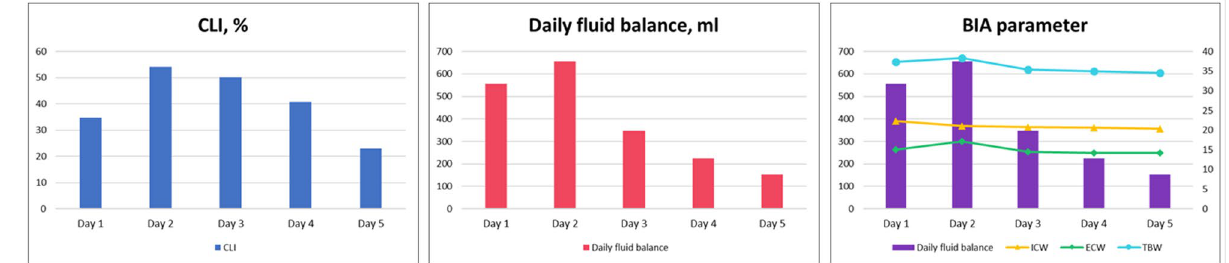
Figure 2. Daily variations of each volumetric variable during the first 5 days after estimated blood loss between 300 and 1000 ml during surgery were 151 (79.5%), those with minimal bleeding of less than 100 ml were 16 (8.4%), and those with massive bleeding of 1500 ml or more were 11 (5.8%). The amount of estimated blood loss of the participants was checked the normality and followed a normal distribution. Lengths of ICU stay and hospital stay were 6 ± 7.1 days and 24.3 ± 18.7 days, respectively. Patients with shock status accounted for 17.9%. ICU mortality and in-hospital mortality were 5.3% and 20.5%, respectively (Table 1). Daily values of volume assessment for 5 days are shown in Table 2 and Fig. 2. CLI, daily fluid balance, and ECW ratio had the highest values on Day 2, showing a decreasing trend after that. The number of patients with overhydration status was the highest on Day 1 at 136 (71.6%) and Day 2 at 135 (71.1%), followed by a decline to 55.8% on Day 3. Comparable analyses between OH and NH on Days 1, 3, and 5 are shown in Fig. 3. On Days 3 and 5, SOFA score at ICU admission, postoperative morbidity, and length of hospital stay, length of ICU stay, ICU mortality, and in-hospital mortality were significantly higher in OH than in NH. In the univariate analysis comparing postoperative complications and mortality, the ECW ratio > 0.390 on the postoperative days 1 and 2 did not show any significant results but were only derived significantly on the 3rd day after surgery. On the other hand, the ECW ratios on the days 1 and 2, which are continuous values, were significant. Results of multivariate analysis to identify predisposing factors of postoperative morbidity occurrence and in-hospital mortality are presented in Table 3A,B. Postoperative morbidity [odds ratio (OR) 1.163, 95% CI 1.038–1.304, p = 0.009] and in-hospital mortality (OR 3.151, 95% CI 1.474–6.737, p = 0.003) were significantly more likely to occur in patients with higher SOFA scores at ICU admission. Postoperative morbidity (OR 1.182, 95% CI 1.056–1.323, p = 0.004) and in-hospital mortality (OR 2.040, 95% CI 1.007–4.590, p = 0.045) were more likely to occur in the group of patients with overhydration status on Day 3. For predicting postoperative mor- bidities, cut-off levels of SOFA score at admission and ECW ratio at Day 3 estimated by ROC curve were 3.5 [area under curve (AUC): 0.655; sensitivity, 53.8%; specificity, 71.4%; p-value < 0.001] and 0.3985 (AUC: 0.676; sensitivity, 75.6%; specificity, 55.5%; p-value < 0.001), respectively. (Fig. 4A). In terms of predicting of in-hospital mortality, cut-off levels of SOFA score at admission and ECW ratio at Day 3 estimated by ROC curve were 7.5 (AUC 0.652; sensitivity, 30.8%; specificity, 99.4%; p-value = 0.004) and 0.4145 (AUC 0.673; sensitivity, 58.3%; specificity, 79.2%; p-value = 0.001), respectively (Fig. 4B).